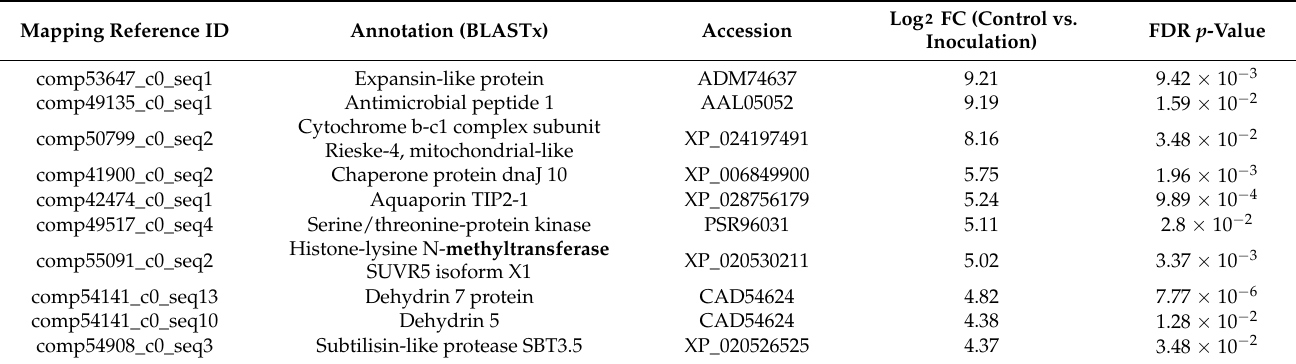
Table 4. Ten most downregulated transcripts after inoculation. Table 3. Eleven (10 annotated) most upregulated transcripts after inoculation (compared to control).